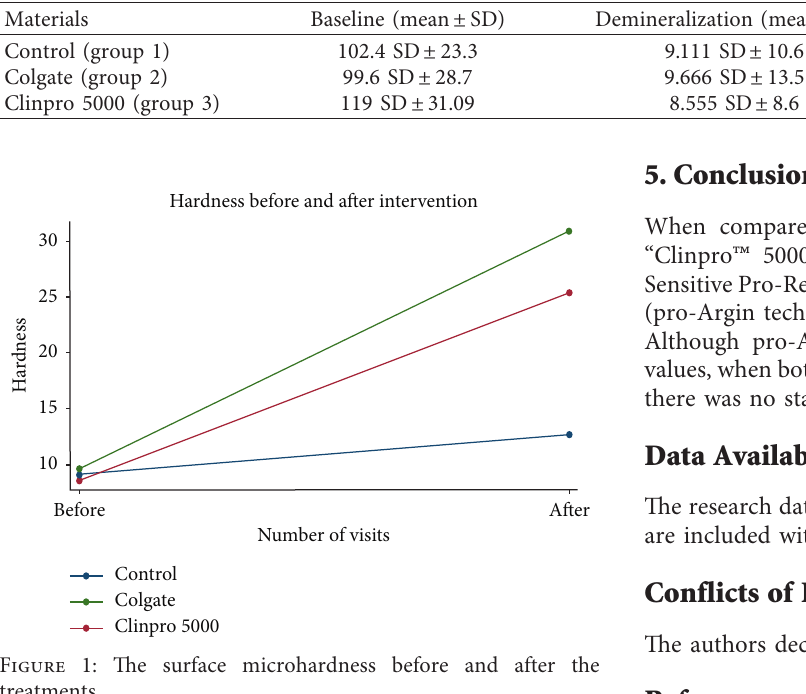
Table 3: Mean SMH of the samples per group at baseline, after demineralization, and after treatment.